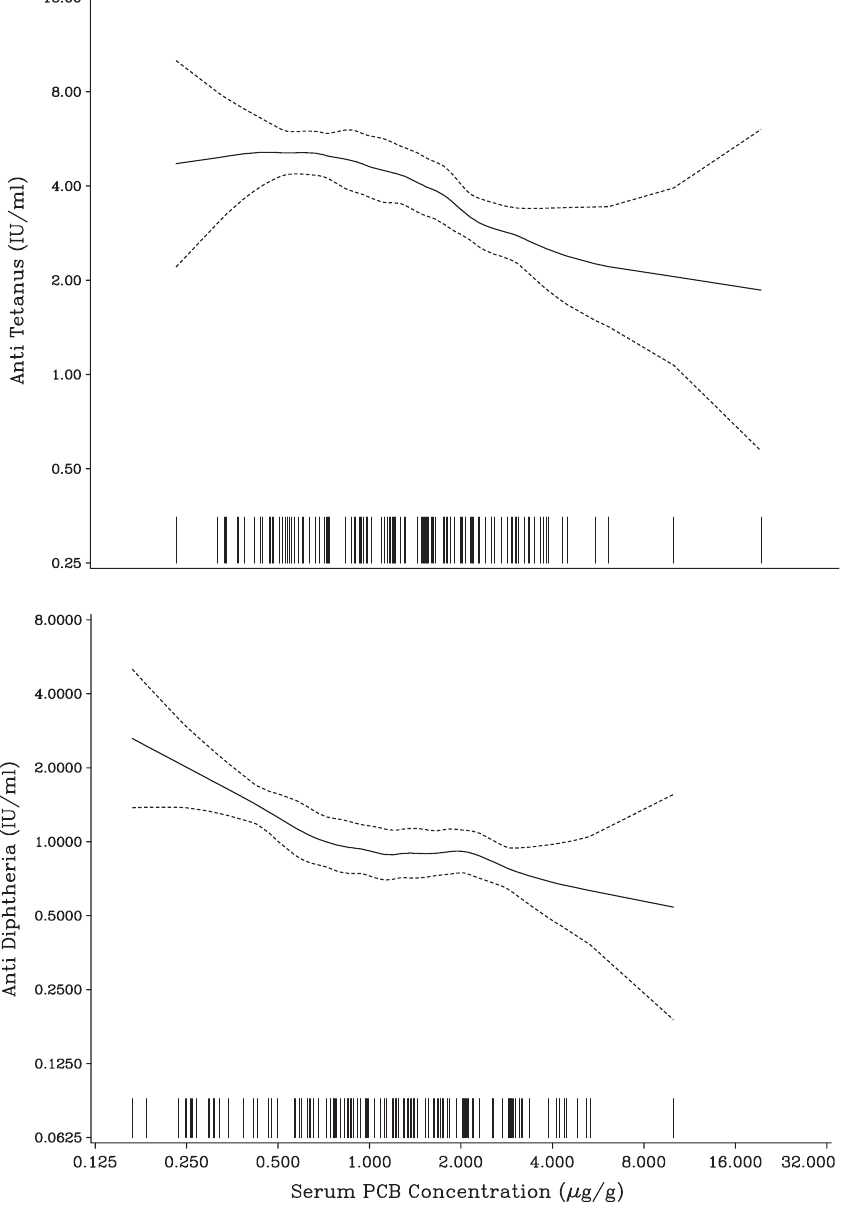
Figure 2. Dose-Effect Relationships between PCB Exposure and Antibody Response to Antigens from Routine Childhood Vaccinations Upper graph, maternal serum concentration of PCBs plotted against serum tetanus antibody concentrations at 7 y of age. Lower graph, maternal serum concentrations of PCBs plotted against serum diphtheria antibody concentrations, both at 18 mo of age. The broken lines indicate the 95% CIs. DOI: